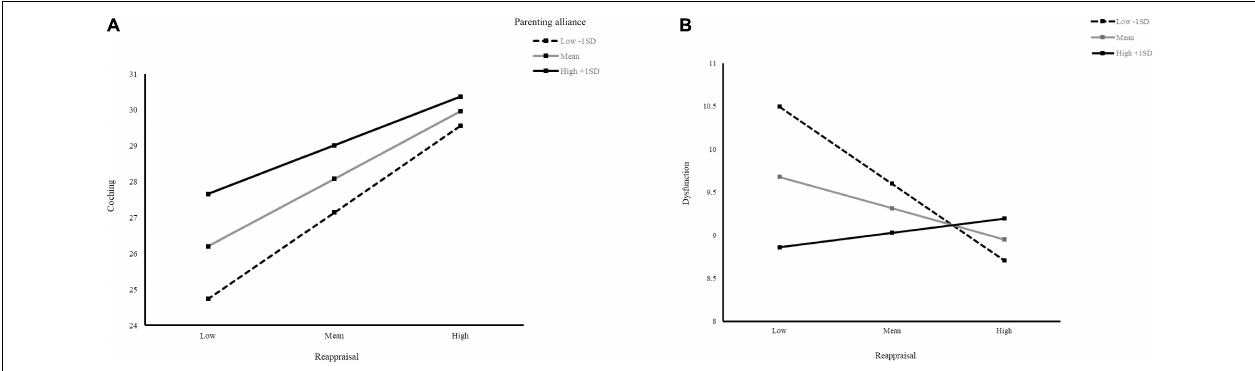
FIGURE 1 | (A) Moderation model of parenting alliance on reappraisal and emotinal-coaching. Slopes of parenting alliance at the mean, as well as ± 1 SD from the mean. Reapprasial is on the x -axis and emotion-coaching is on the y -axis. (B) Moderation model of parenting alliance on reappraisal and emotinal-dysfunction. Slopes of parenting alliance at the mean, as well as ± 1 SD from the mean. Reapprasial is on the x -axis and emotion-dysfunction is on the y